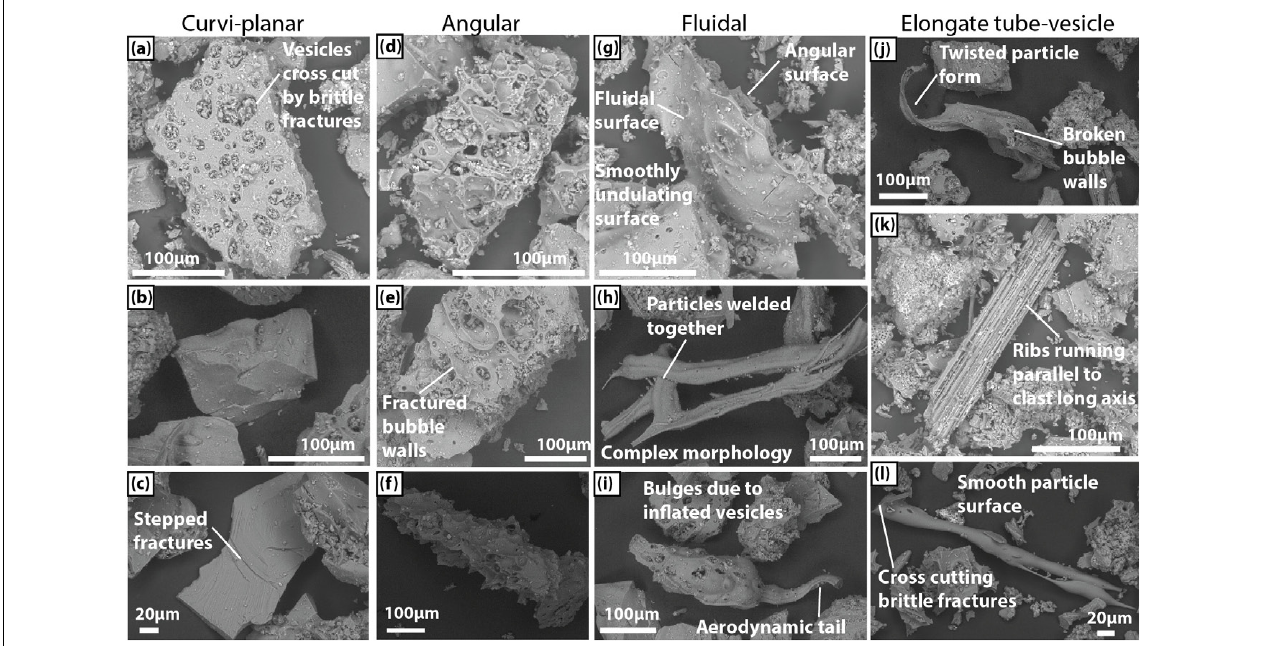
FIGURE 7 | SEM images of representative particles from the different componentry classes; curvi-planar (a–c) , angular (d–f) , fluidal (g–i) , and elongate tube (j–l) . In curvi-planar clasts, fracture surfaces cross cut vesicles. Angular particles are bound by fractured vesicle walls with grain morphology dominantly controlled by vesicle texture (d–f) . Fluidal particles are defined based on features that are indicative of molten behavior syn/post-fragmentation. This includes ductile reshaping (g) , particle welding (h) , and post-fragmentation vesicle inflation (i) . (j–l) Clast-surface textures of elongate tube particles. Note the different scales across